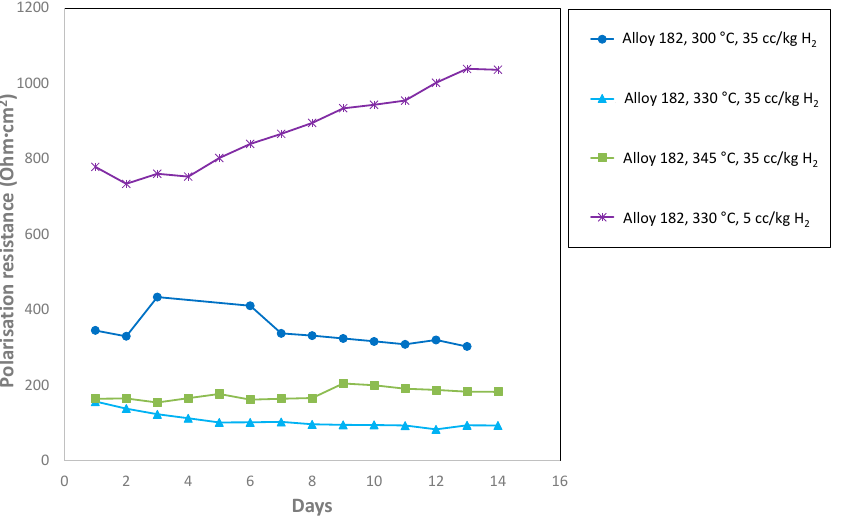
Figure 12. Modulus of the impedance at low frequency as a function of time.